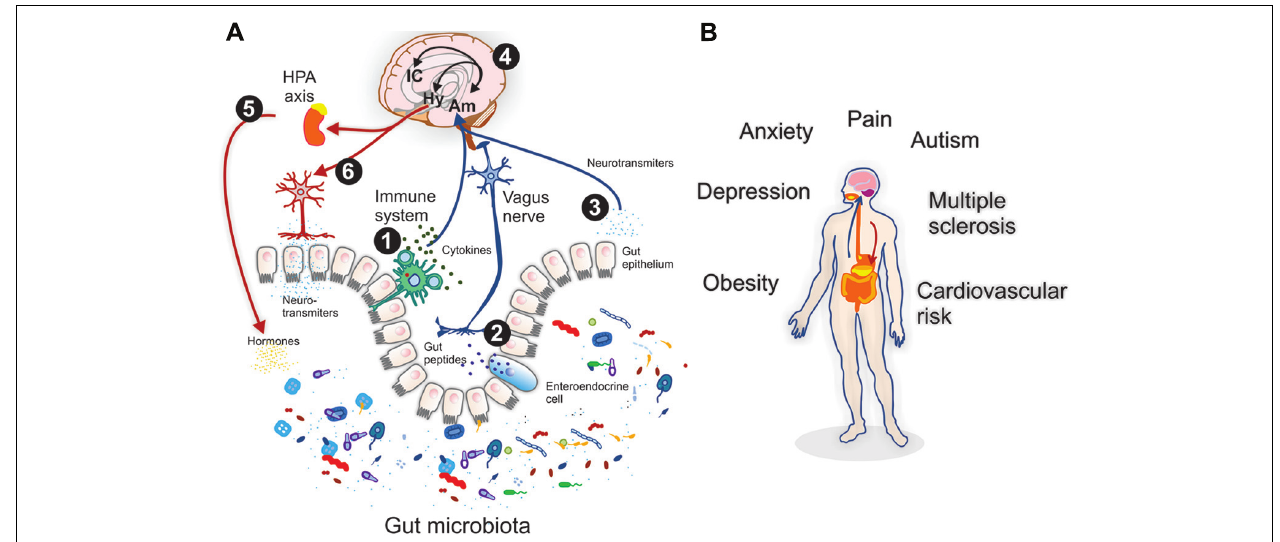
release as results of the hypothalamic–pituitary–adrenal (HPA) axis activation, modulates gut microbiota composition. (6) Neuronal efferent activation may include the so called “anti-inflamatory cholinergic reflex” and/or sympathetic activation, both liberating classical neurotransmitters that may affect directly the gut microbiota composition. (B) Health conditions affected by the MGB axis. Recent and growing evidence suggests that several health conditions may be affected by intestinal microbiota, including: visceral pain (McKernan etal., 2010;Wang etal., 2010; Clarke etal., 2012), autism spectrum